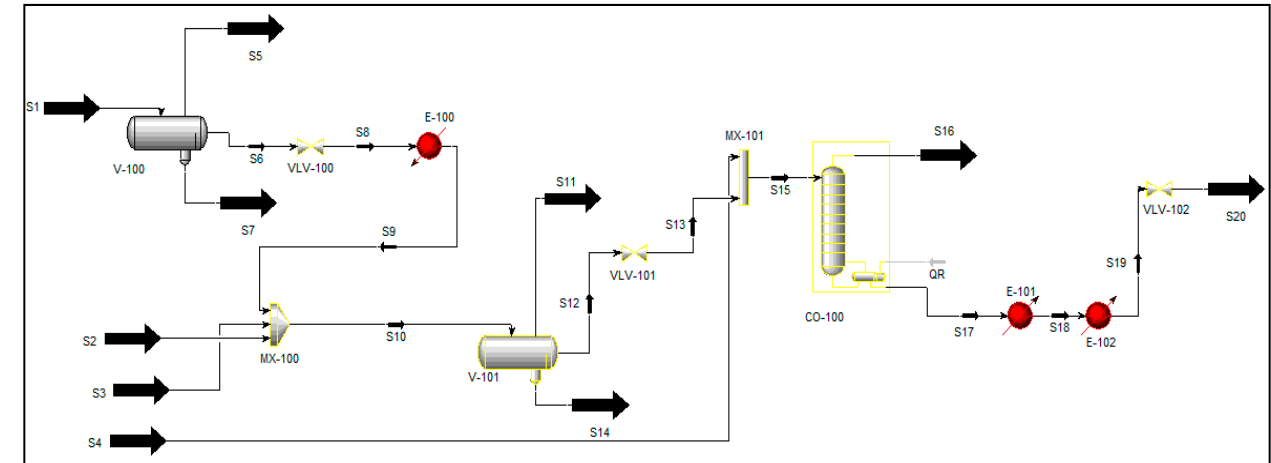
Figure 1. A process flow diagram for the separation process of reservoir fluid developed using HYSYS.